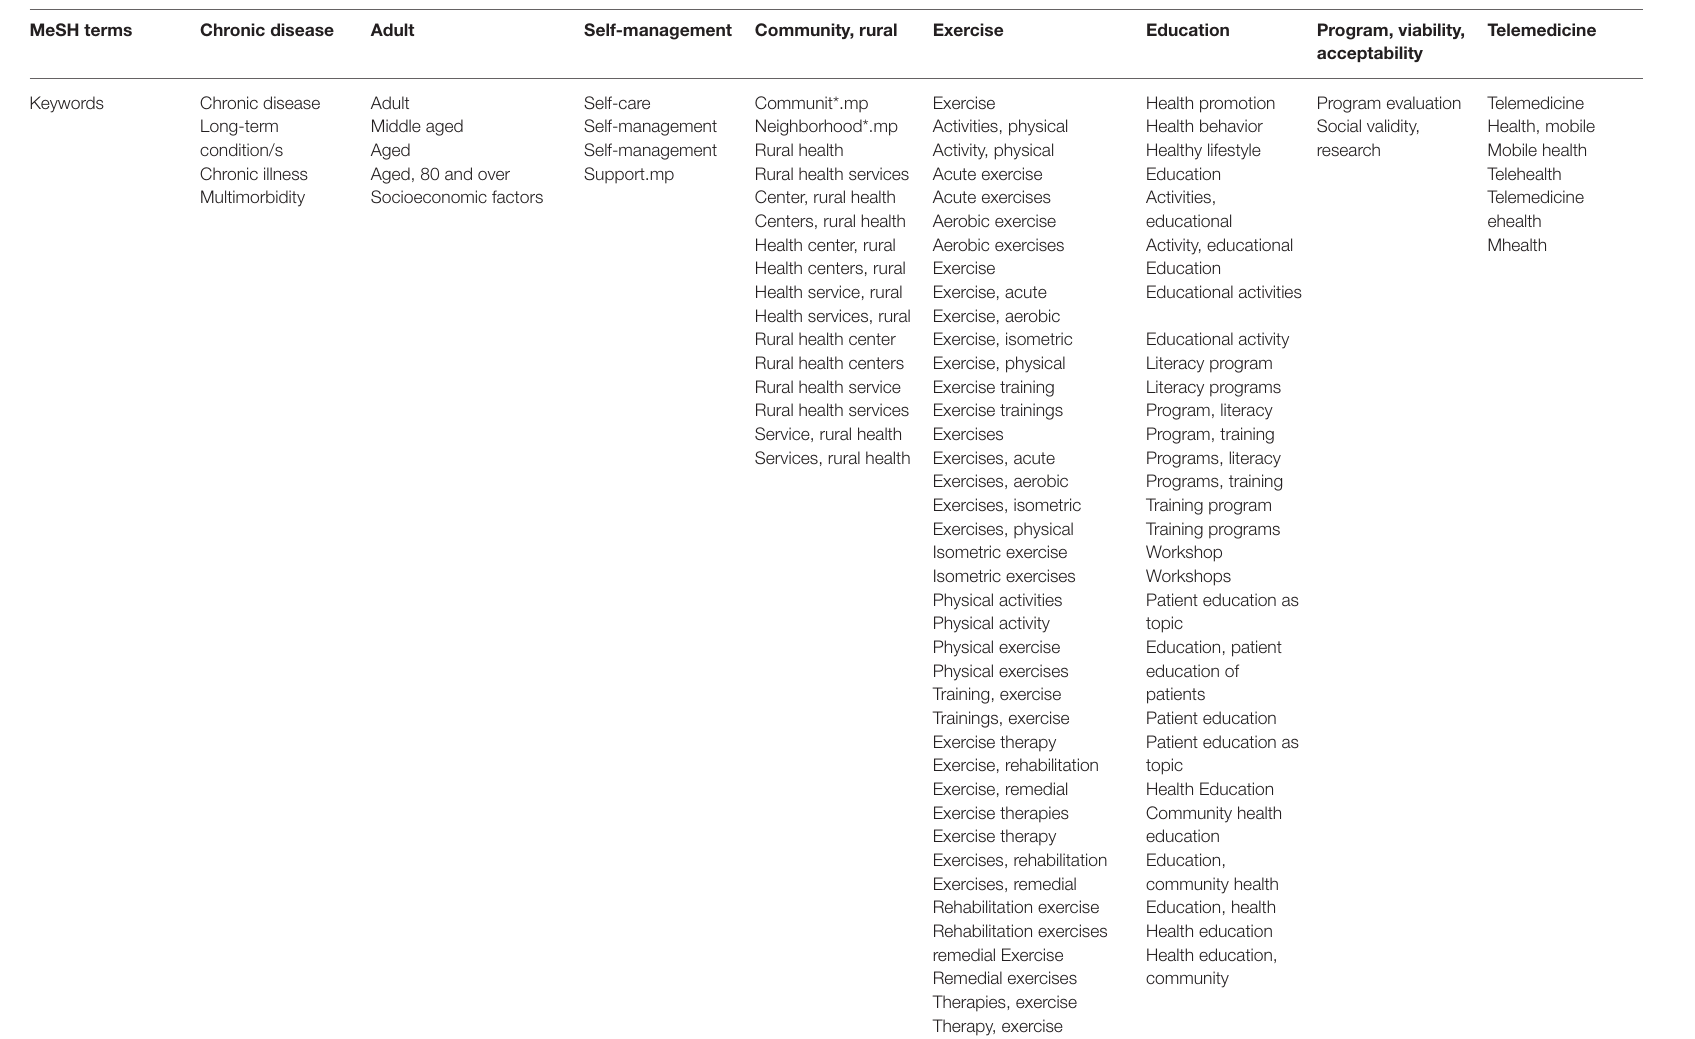
TABLE 1 | Generic database list of MeSH and keyword search terms. MeSH